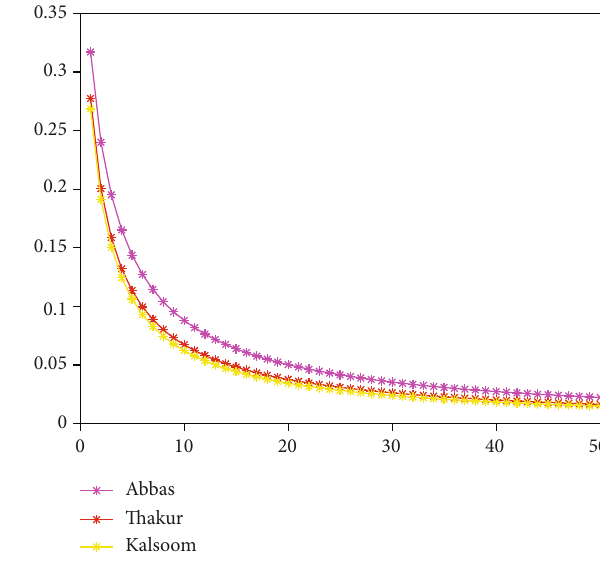
Figure 1: Convergence behavior of Mann, Ishikawa, and Kalsoom et al. iterations towards fi xed point.